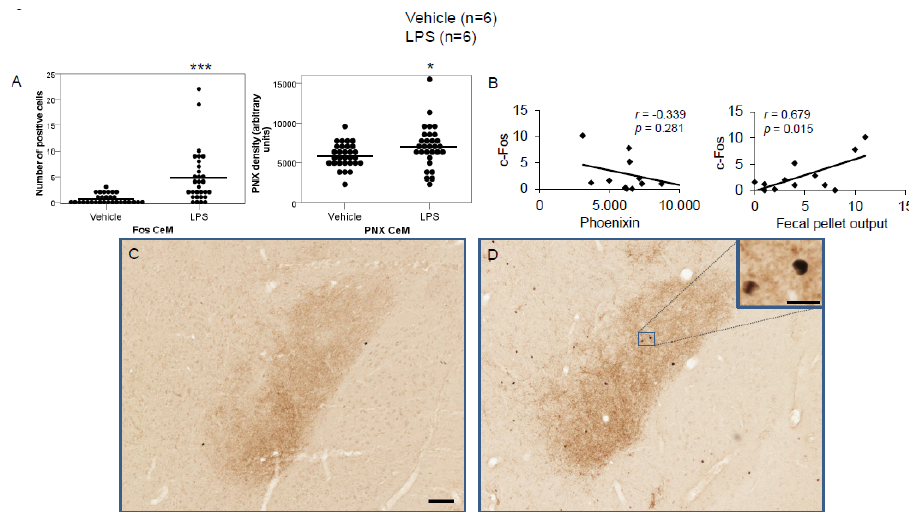
Figure 2. LPS stimulates c-Fos and phoenixin expression in the medial division of the central amygdaloid nucleus. Ad libitum-fed rats were subjected to IP injection of LPS or control, and 180 min after the injection, brains were processed for c-Fos and phoenixin double-immunohistochemistry. LPS stress significantly increased the number of c-Fos-positive cells and phoenixin density compared to controls ( A ). No significant correlation was observed between c-Fos and phoenixin immunoreactivity, while the number of c-Fos positively correlated with fecal pellet output ( B ). Representative pictures of the evaluated slides are shown in ( C ) (control) and ( D ) (LPS). The scale bar represents 100 µ m in the overview and 20 µ m in the insert. Data are expressed as individual data points (5/animal) and mean in ( A ). Mean values per animal are plotted in ( B ). * p < 0.05, *** p < 0.001. Abbreviation: CeM, central amygdaloid nucleus, medial division.